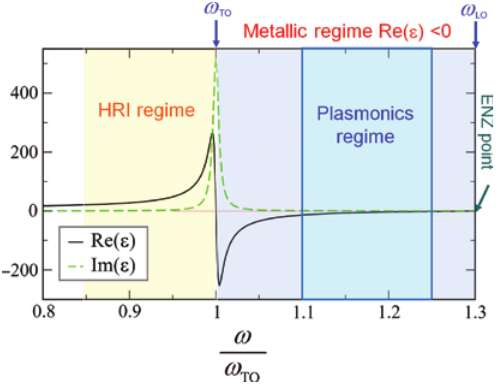
Figure 13: Photonic responses of isotropic PhP media.